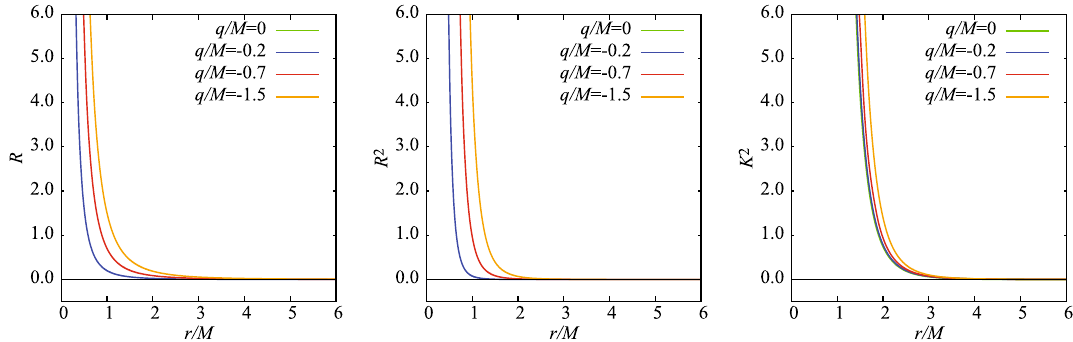
Fig. 2 The Ricci scalar ( R ), the square of Ricci tensor ( R 2 ) and the Kretschmann scalar ( K 2 ) as a function of the radius r / M for the metric of the hariy black